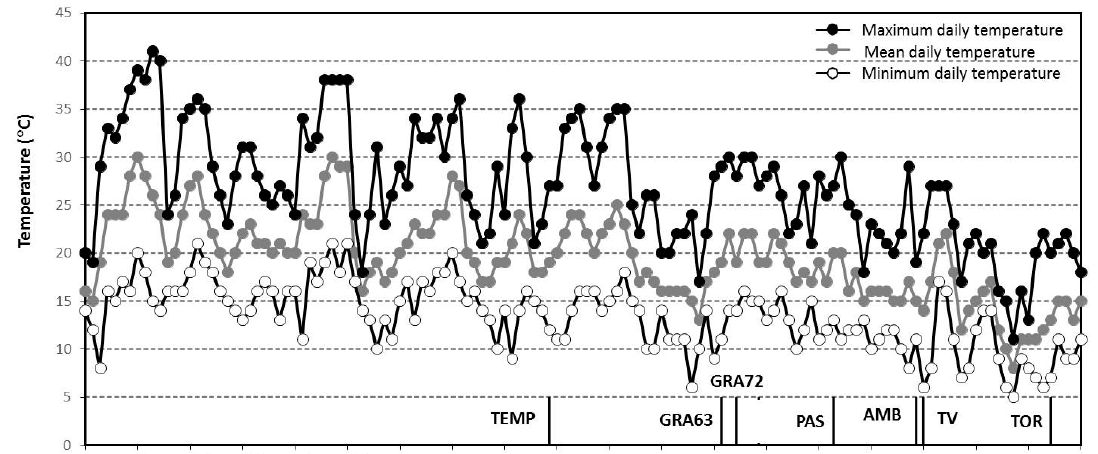
Figure 5. Time course of minimum, maximum, and average air temperature recorded from fruit set to maturity of berries. Bars indicate the average harvest date of each genotype. Genotype labels can be found in Table 5.